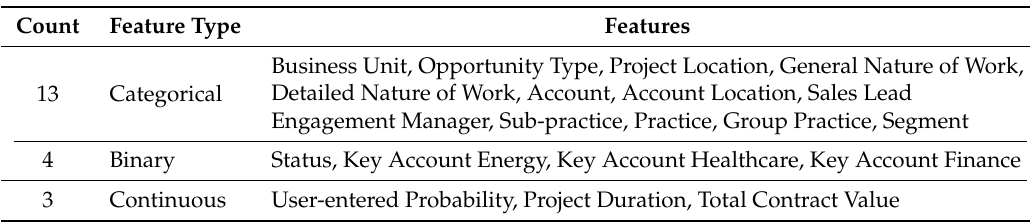
Table 1. Raw CRM sales database